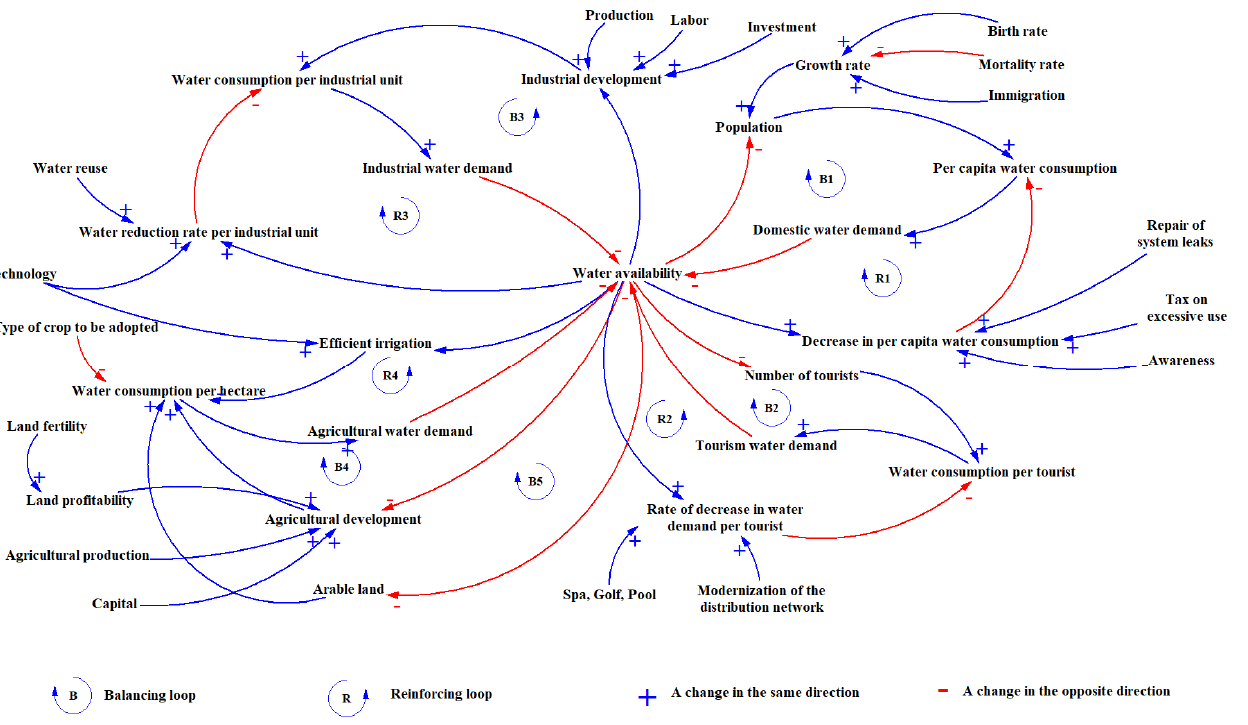
Figure 2. Causal loop diagram mapping the key parameters that impact water demand in the Souss-Massa basin.